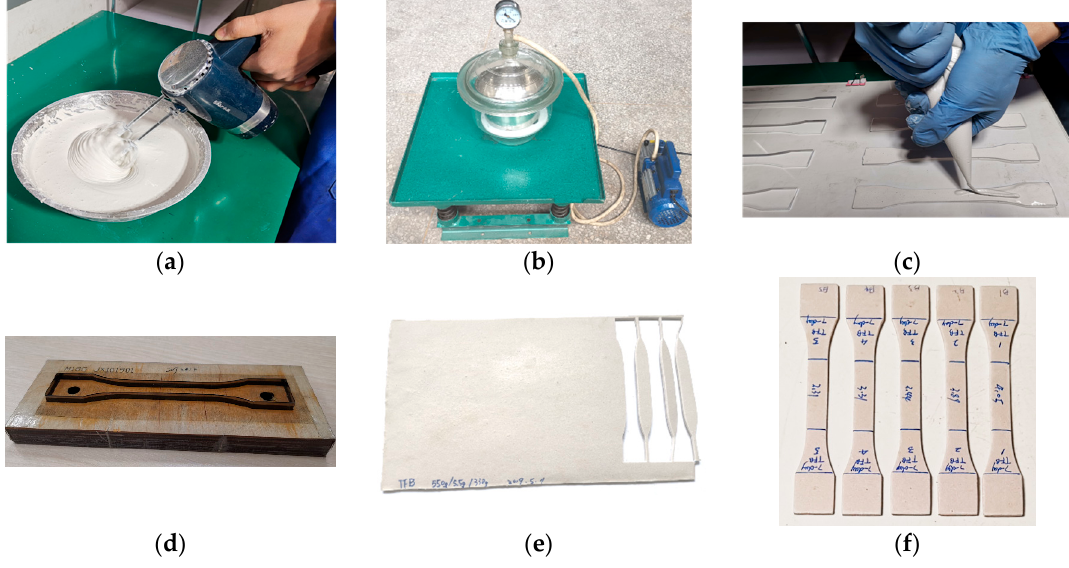
Figure 2. Specimen preparation. ( a ) mixing with a kitchen mixer, ( b ) vibrating and vacuuming, ( c ) dogbone molding, ( d ) die cutter, ( e ) sheet for die cutting, ( f ) specimens by die cutting.